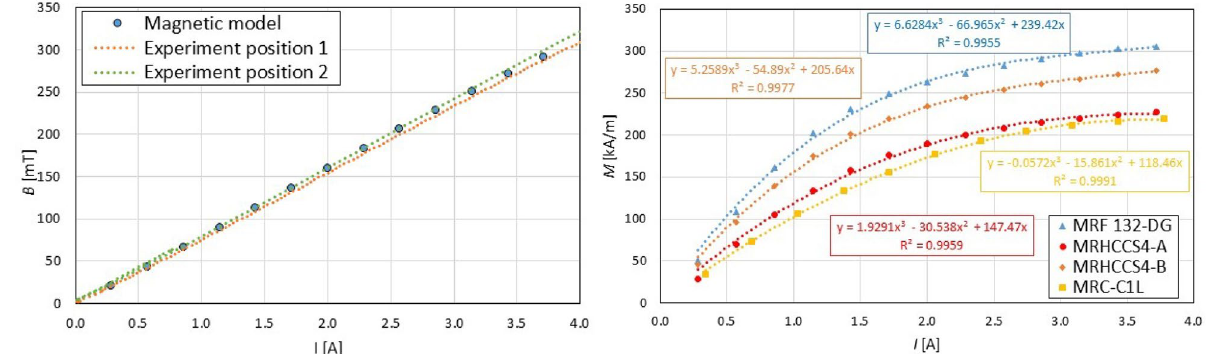
Figure 3. The results from the magnetic model and experiment for air gap (left), The calculated magnetization M dependency of electric current I on the coil for different MR fluids (right).